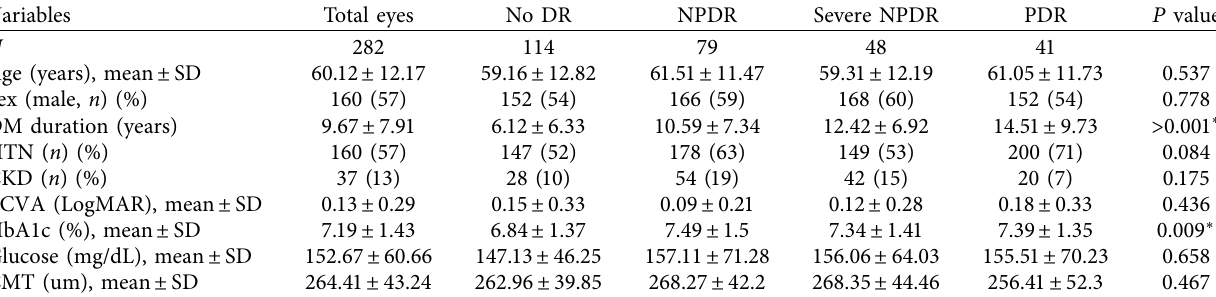
Table 1: Clinical characteristics of study eyes.